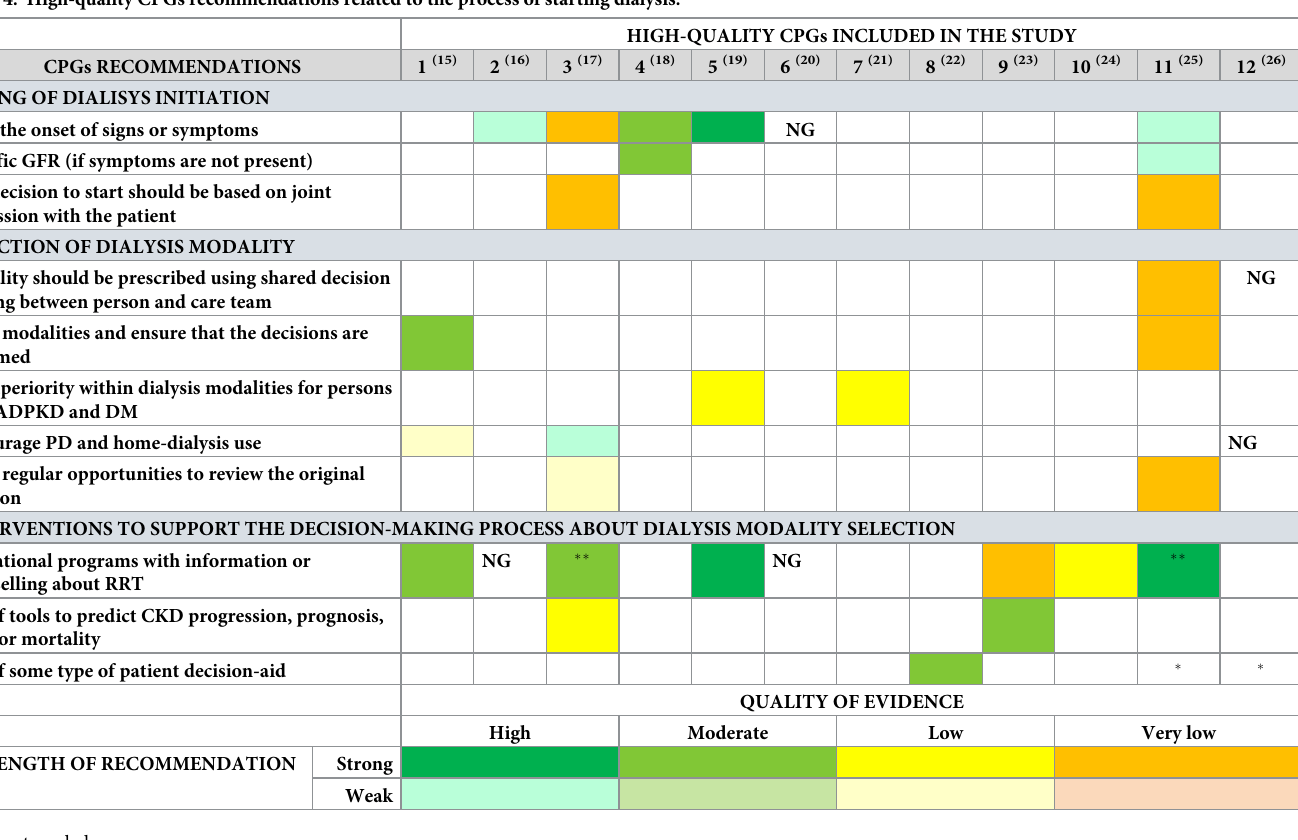
Table 4. High-quality CPGs recommendations related to the process of starting dialysis.